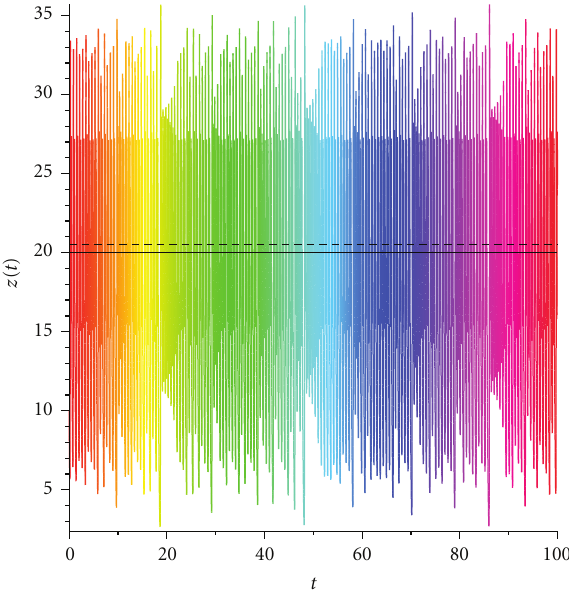
F 2: e chaotic time series of and with two straight lines (solid) and (long 𝑦𝑦 𝑥 20